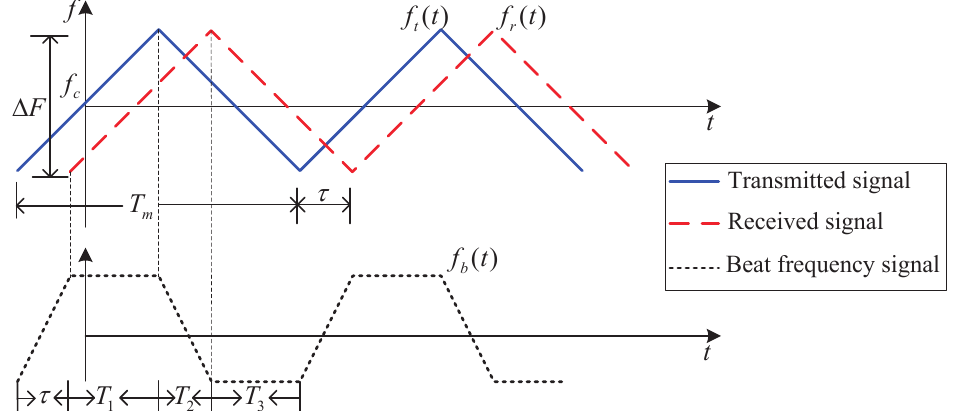
Figure 1. Instantaneous frequency of the transmitted and received signals for relatively stationary sensor and